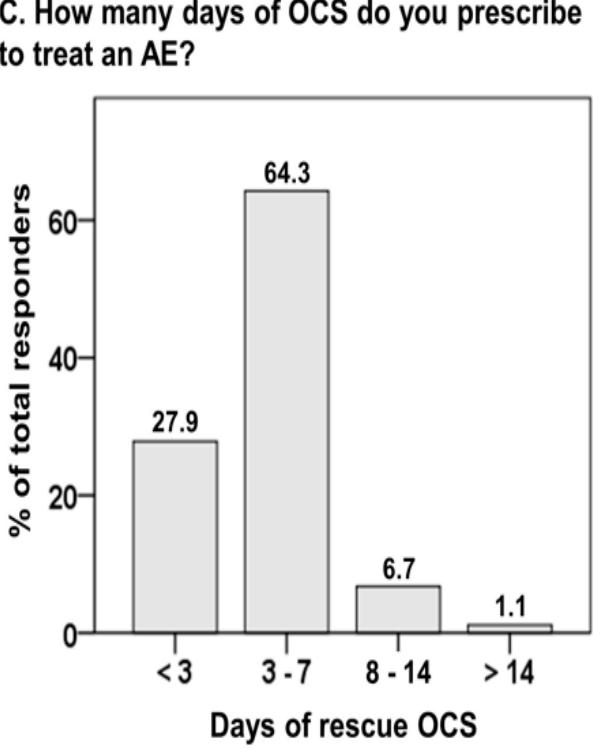
Figure 1. The proportion of responses to questions regarding oral corticosteroids for acute exacerbation of asthma. AE, acute exacerbation; OCS, oral corticosteroid. * indicates prednisone or equivalent in mg.